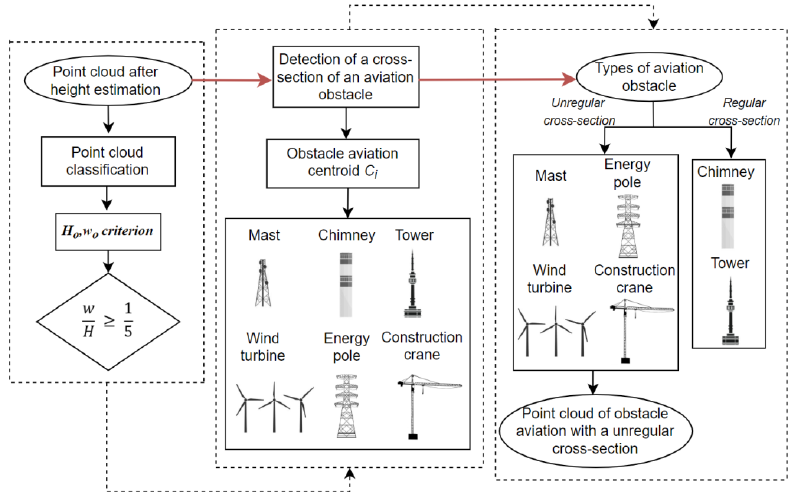
Figure 5. Scheme of classification of point cloud.